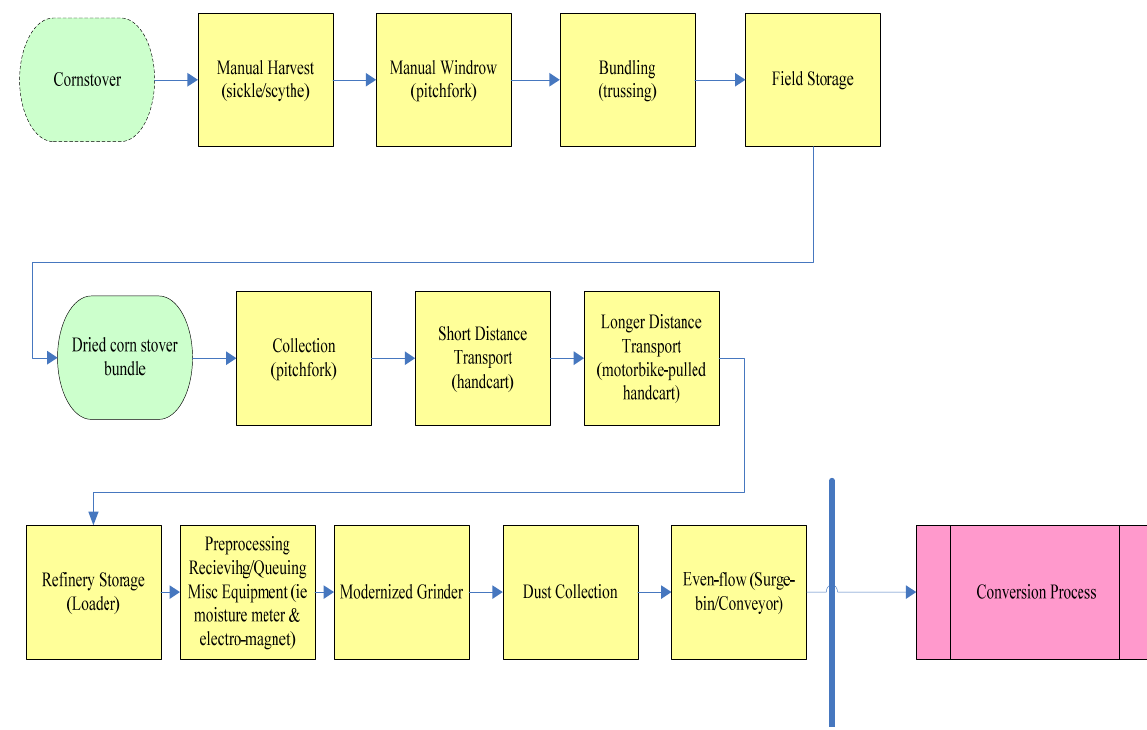
Figure 1. BLM–SinoFS process flow assumptions based on existing agricultural